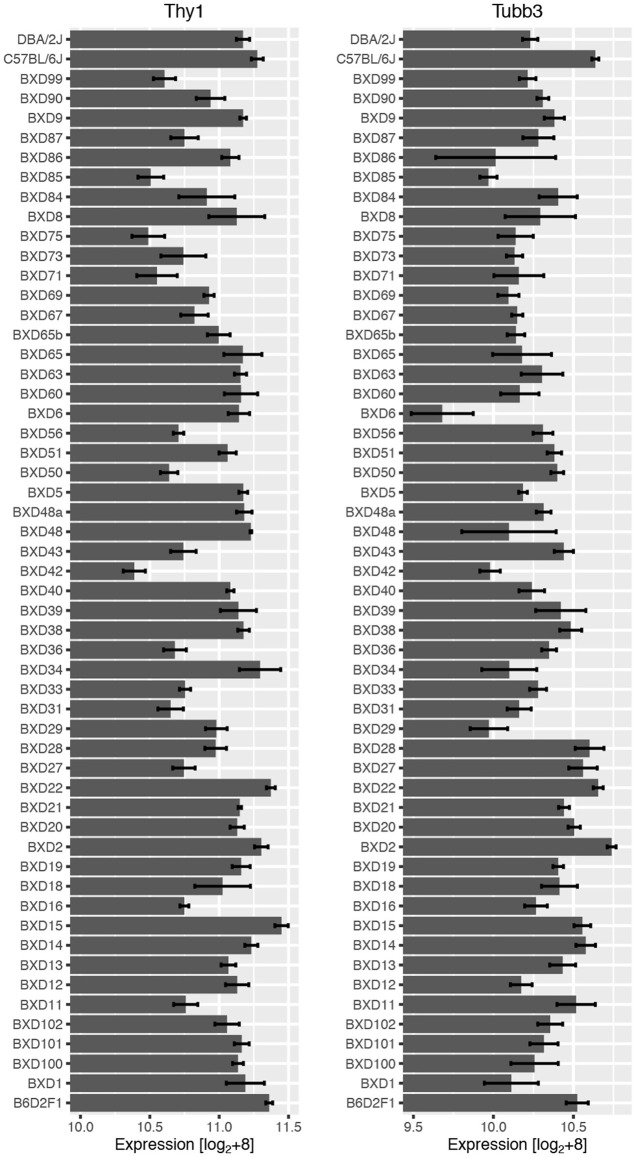
RNA expression across the BXD RI strain set for Thy1 (left) and Tubb3 (right) with the means and standard errors. There was an approximately 2-fold difference in mean expression levels for both genes. This data is given as raw expression values on a log2 scale +8.